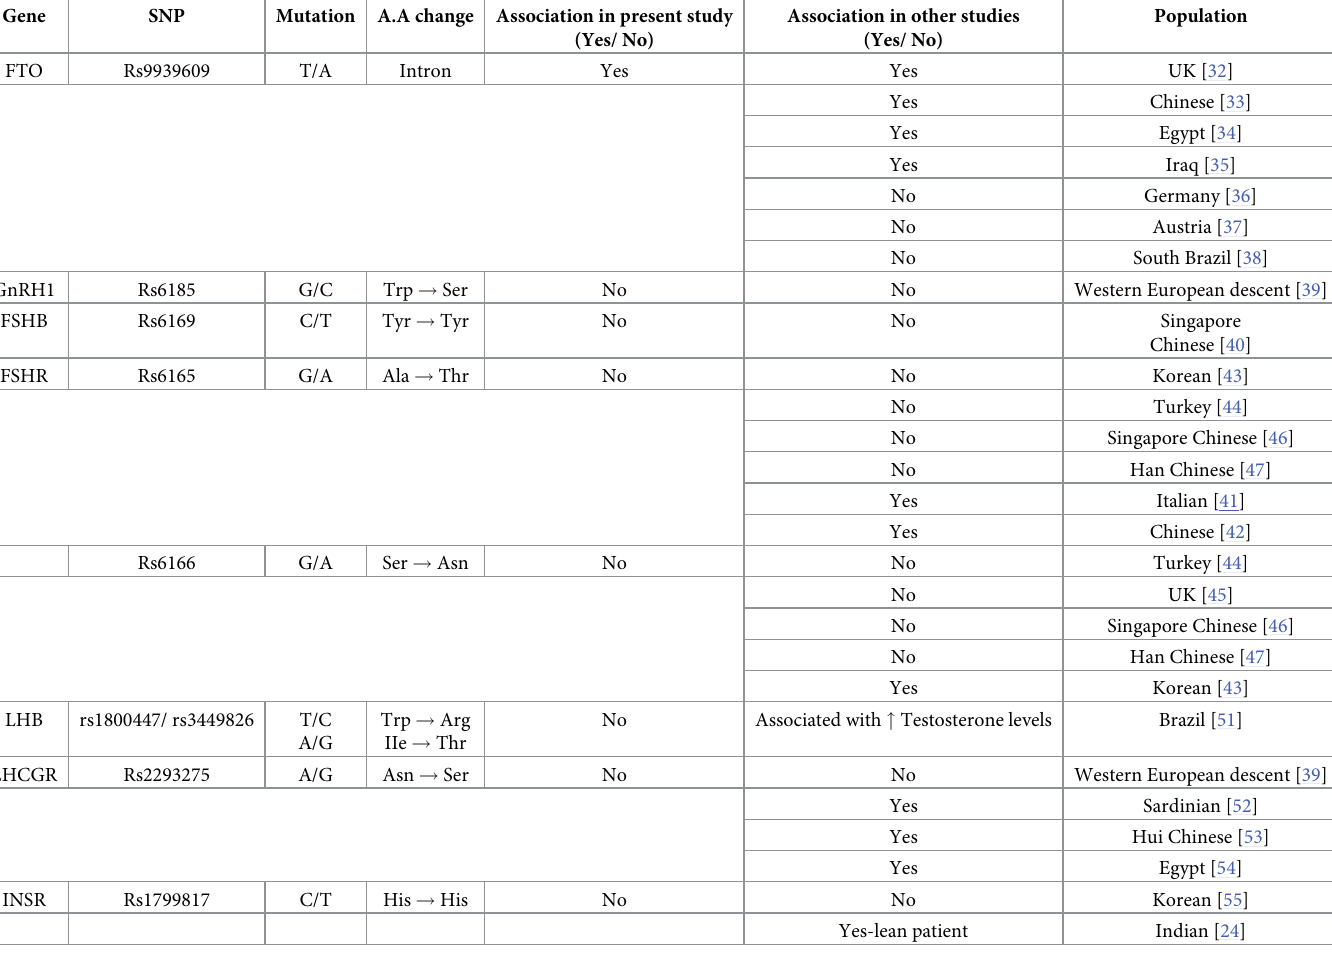
FTO—Fat mass and obesity-associated gene; FSHB—Follicle stimulating 348 hormone beta subunit; FSHR—Follicle-stimulating hormone receptor; INSR—Insulin receptor; GnRH—Gonadotropin-releasing hormone; LHB—Luteinizing hormone beta subunit; LHCGR -Luteinizing hormone/choriogonadotropin